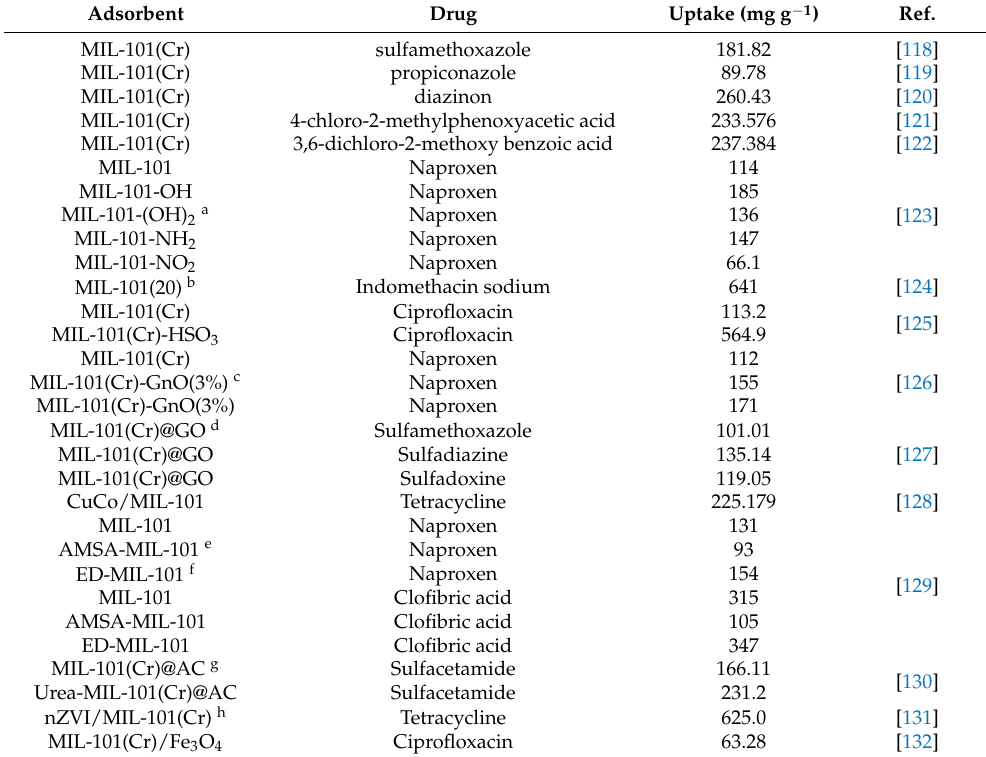
Table 4. Summary of drugs adsorption for MIL-101(Cr) or MIL-101(Cr)-based